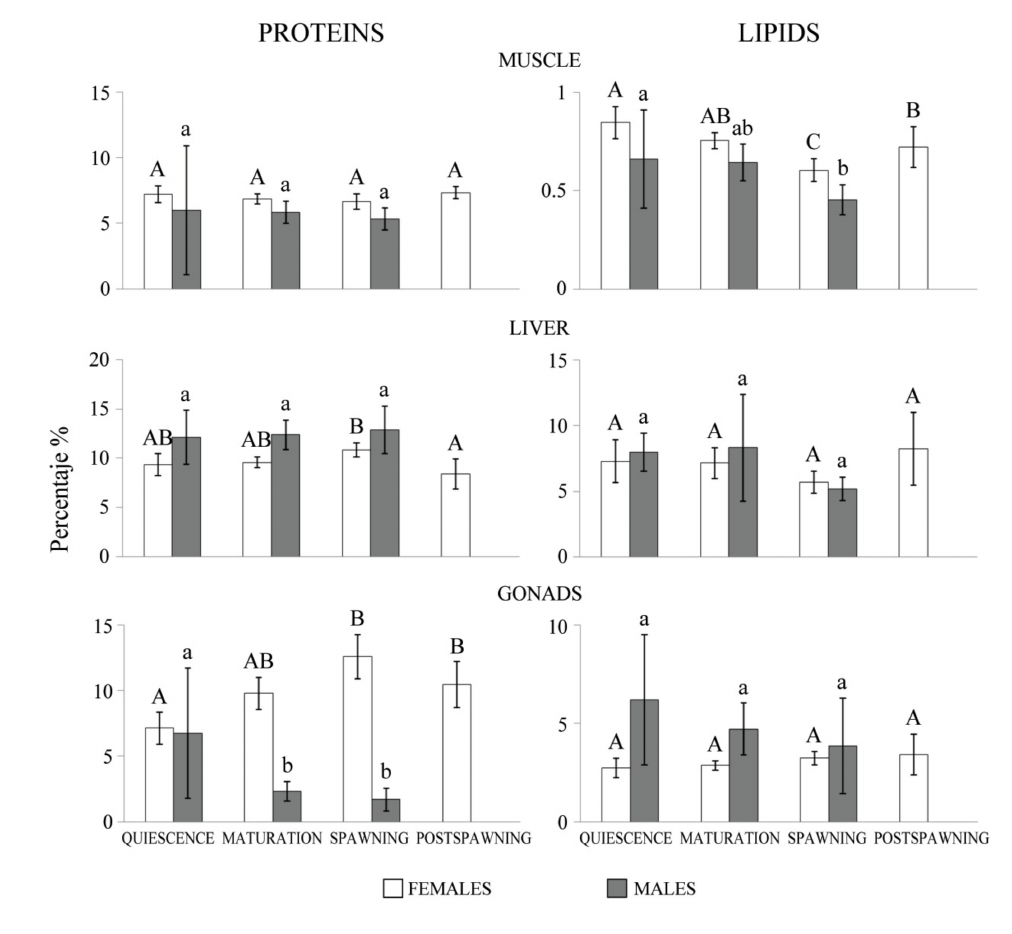
Figure 6. Mean and ± IC 95% percentages of proteins and lipids in muscle, liver and gonads by reproductive stages. White bars represent female values and grey bars represent the male ones. The letters show significant differences (ANOVA, p < 0.05) among reproductive stages by post hoc comparison Tukey test. Capital letters for female data and lower case letters for male